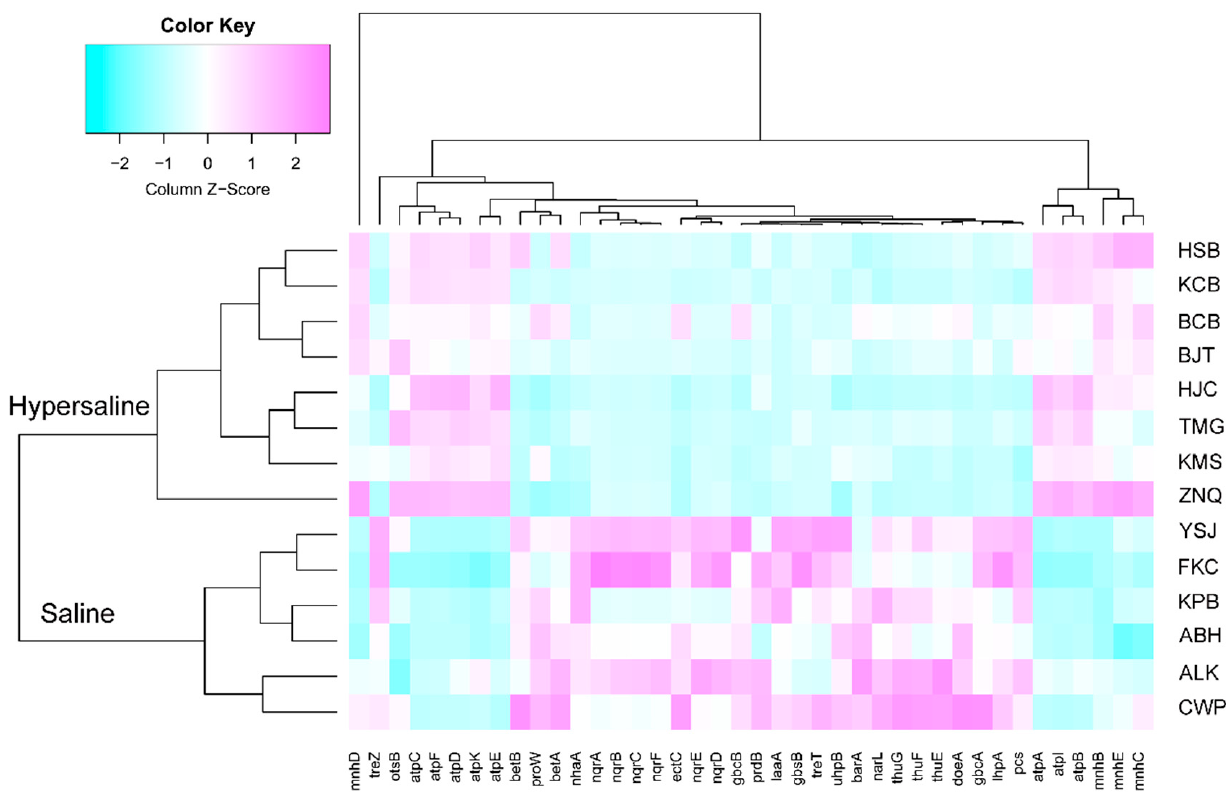
Figure 11. Heatmap of significantly different genes (FDR < 0.05) between the saline and hypersaline soils involved in compatible organic osmolytes synthesis and metabolism and ions flux controlling channel aquaporin.